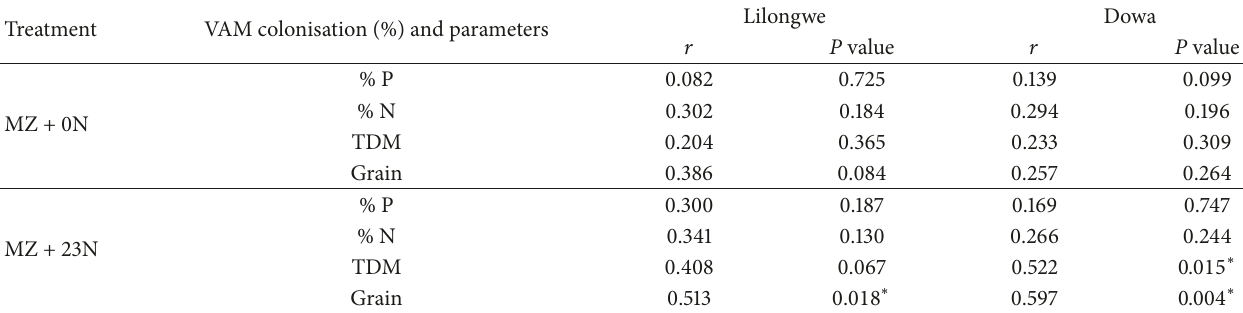
Table 3: Pearson correlations between VAM colonisation percentages and plant tissue P concentration (% P), plant tissue nitrogen concentration (% N), total dry matter, and grain yields for year